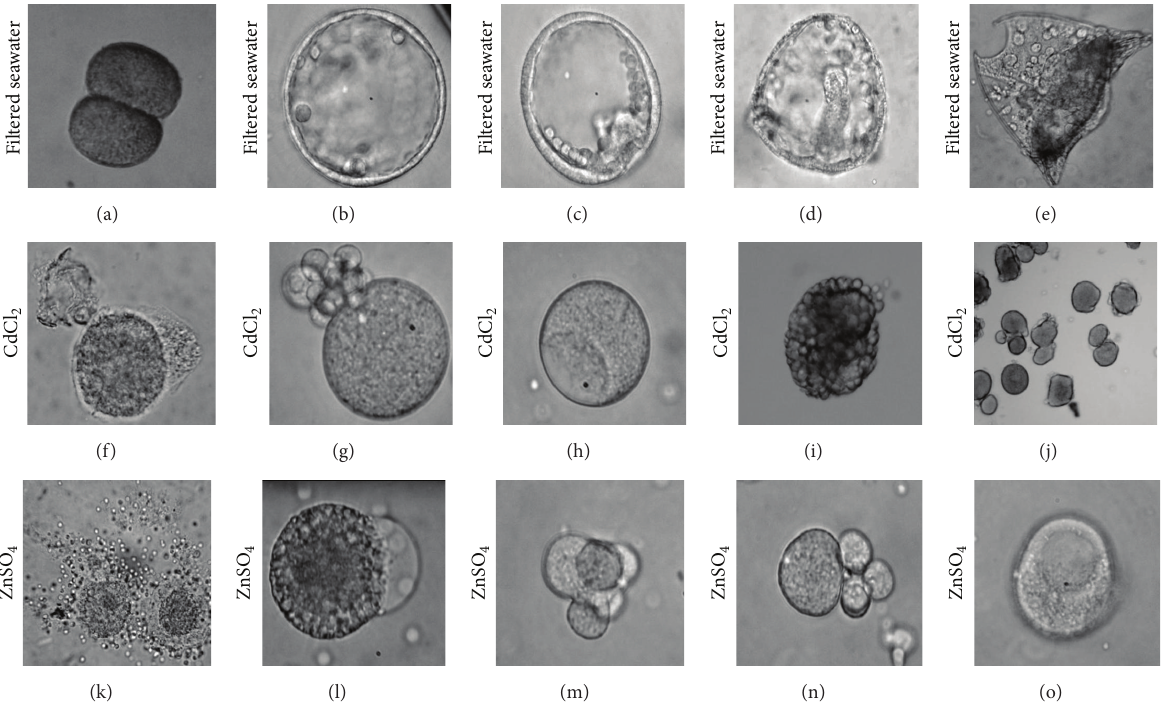
Figure 5: The embryonic development of T. gratilla. Normal development observed starting from 2-cell up to 2-arm echinopluteus on the control (filtered seawater; a–e) and abnormalities in the embryos observed under the highest nongametotoxic concentrations of CdCl 2 (f–j) and ZnSO 4